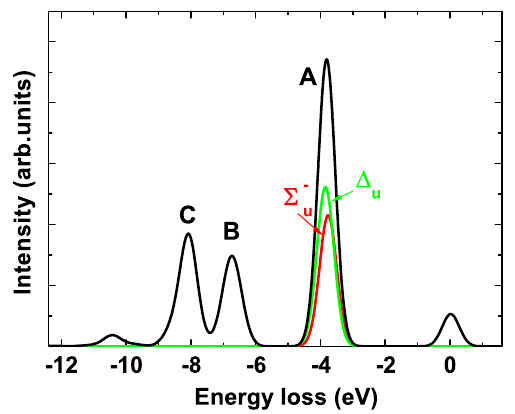
FIG. 5. Calculated S K β RIXS spectrum of the CS 2 molecule at the 1 s → 3 π LUMO resonance (black line), corresponding to u the spectrum shown in Fig. 2 at Ω ¼ 0 . The arrows show the symmetry-forbidden ungerade final states j 2 π − 1 to the dominant band